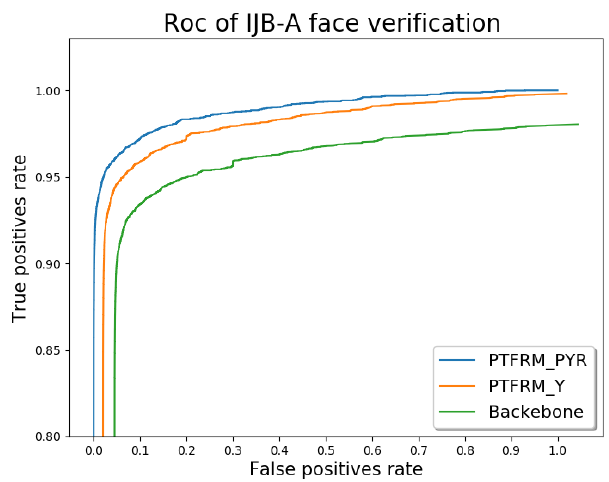
Figure 15. Receiver operating characteristic(ROC) comparison of IJB-A face verification (1:1).